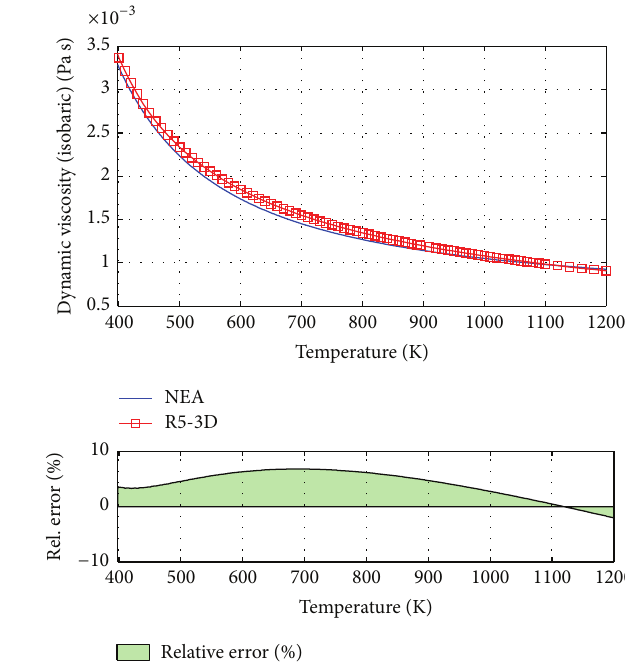
Figure 6: LBE liquid dynamic viscosity original R5-3D “tpf” file versus NEA report.